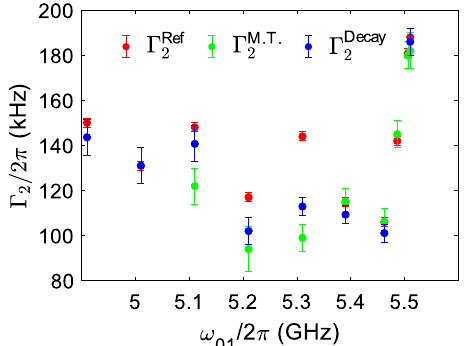
Fig. 10 Comparison the values of Γ 2 extracted from different methods. Γ Ref , Γ M : T : and Γ Decay 2 2